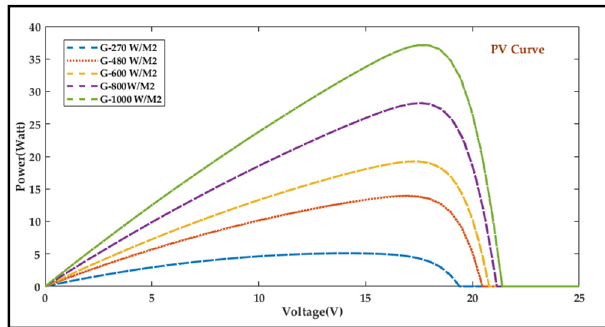
Figure 7. P-V curve of PV panel.